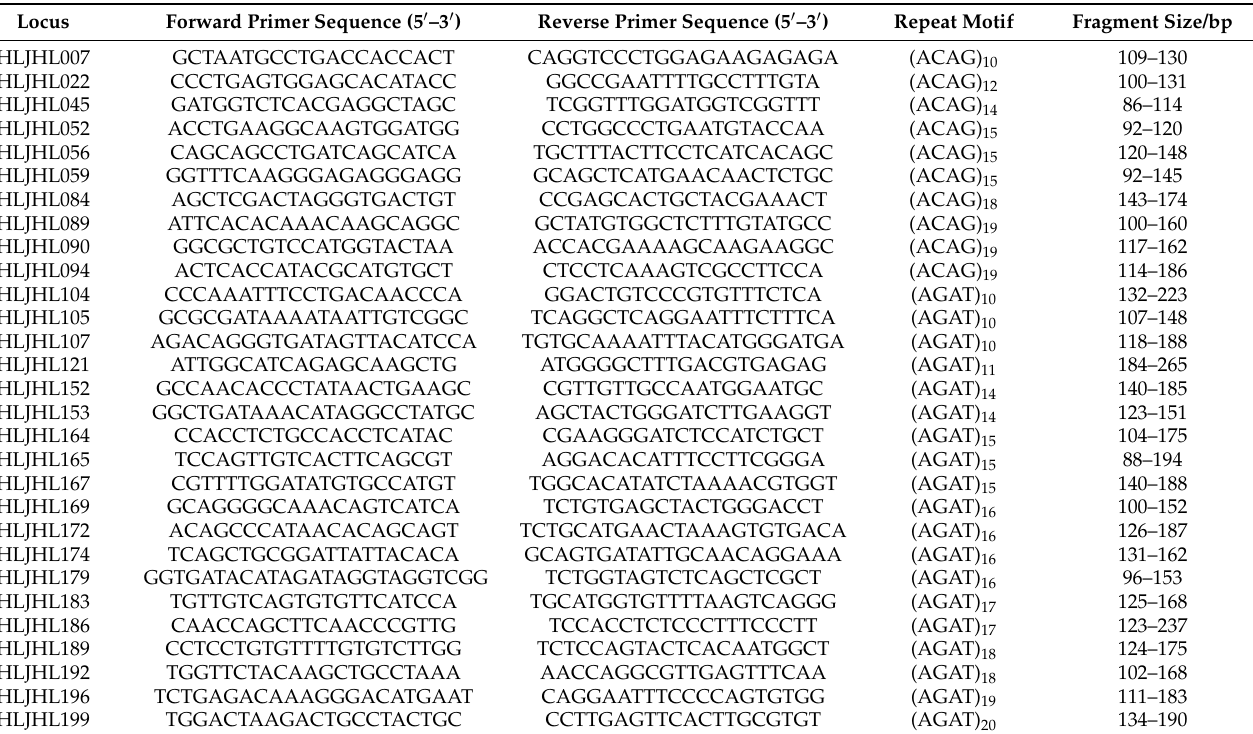
Table 1. Microsatellite primer sequences and amplification information for P. fluviatilis .